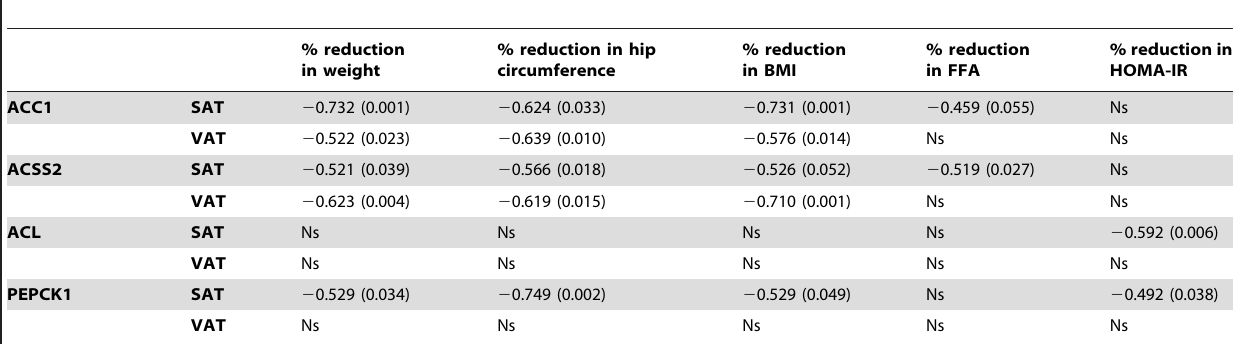
Table 2. Significant correlations ( p ) found between basal mRNA expression and the anthropometric and biochemical variables studied.